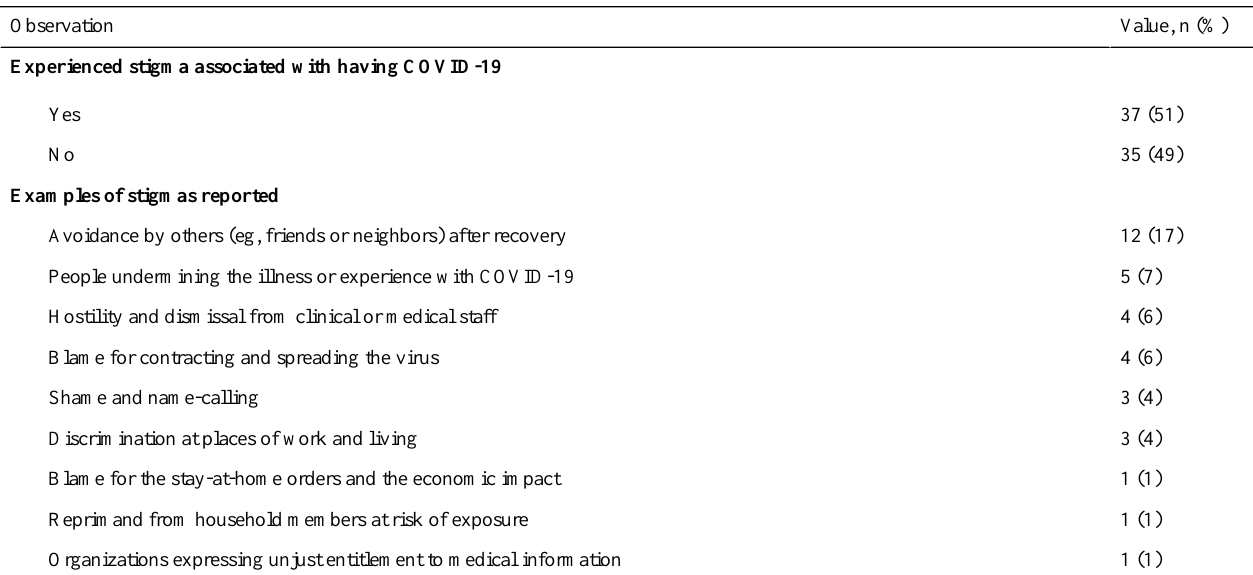
Value, n (%)Observation